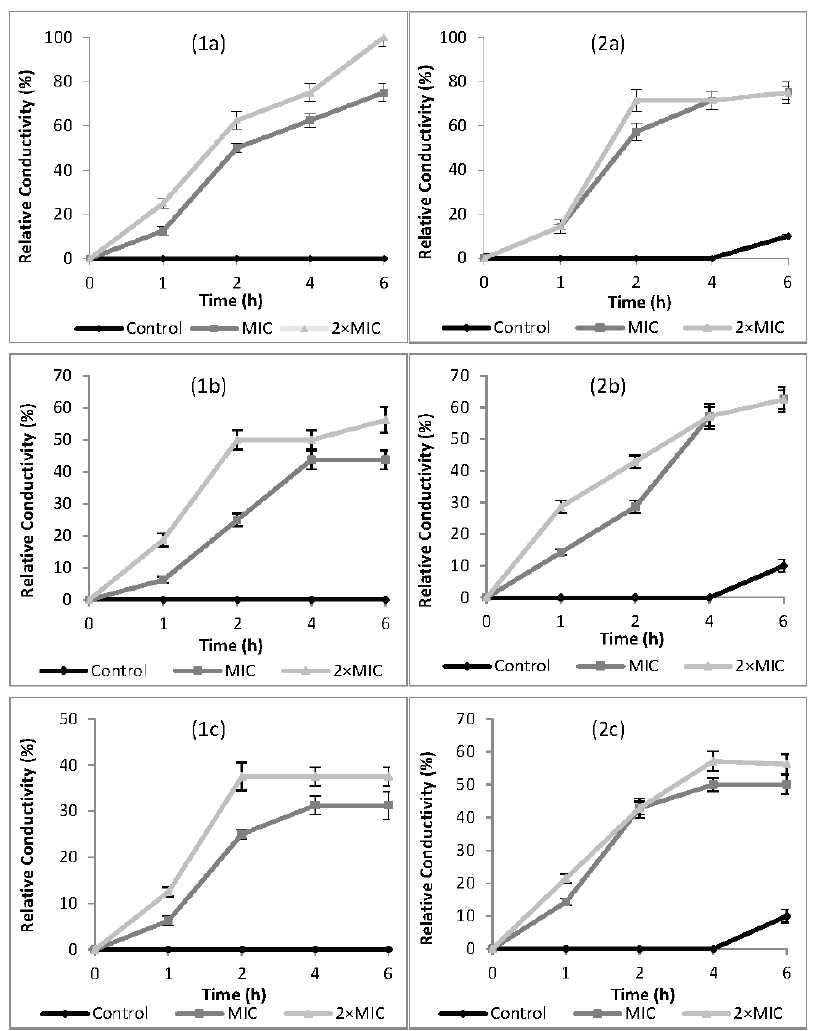
Figure 1. Effect of cardamom ( a ), cumin ( b ), and dill weed ( c ) essential oils on cell membrane permeability of Campylobacter jejuni (1) and Campylobacter coli (2), MIC: Minimum inhibition concentration.